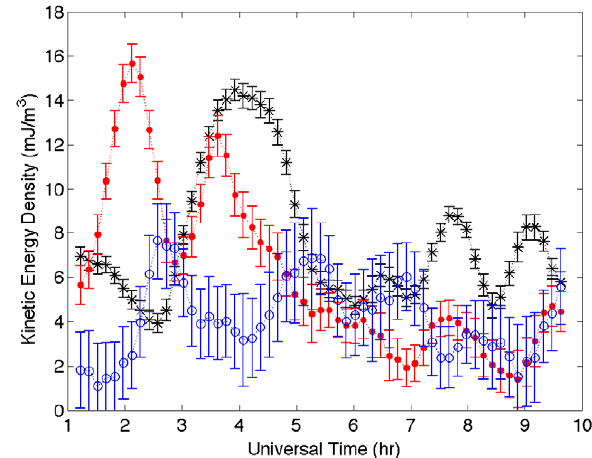
Fig. 2. Kinetic energy density on 6 April 1998 in the same for- Figure 2. Kinetic energy density on April 6, 1998 in the same format as Figure 1. Potential mat as Fig. 1. Potential energy per unit mass (J/kg) can be found energy per unit mass (J/kg) can be found by multiplying the KED by: 2.3 (Low), 0.46 (Middle) by multiplying the KED by: 2.3 (Low), 0.46 (Middle) and 0.052 and 0.052 (High).